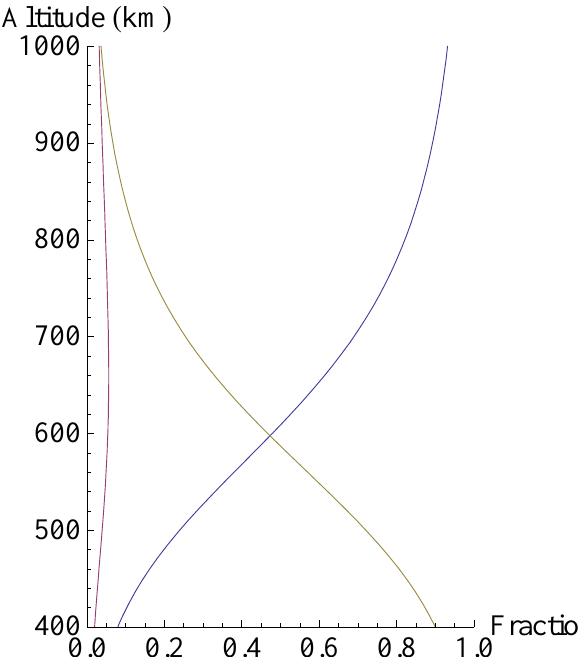
Fig. 6. Plot of Eq. (5) for a 3-ion plasma versus altitude above a 400km reference altitude where the relative abundances are fixed as O + :H + :He + =0.9:0.08:0.02. The ion species share the same tem- perature, which increases with altitude (see